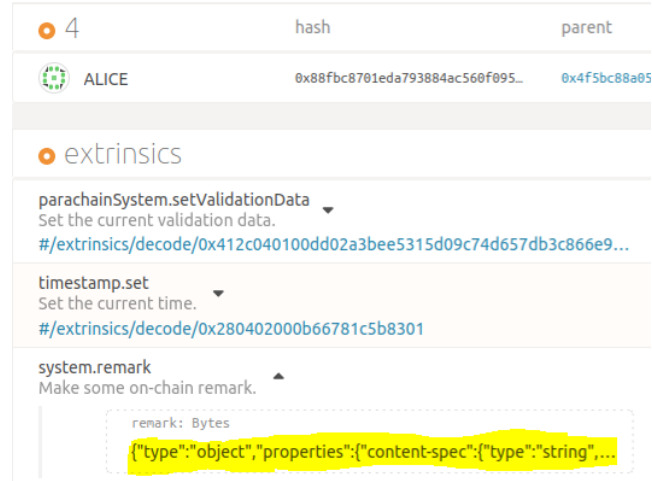
Figure 7. The data model (highlighted) after being retrieved by the Polkadot parachain oracles.